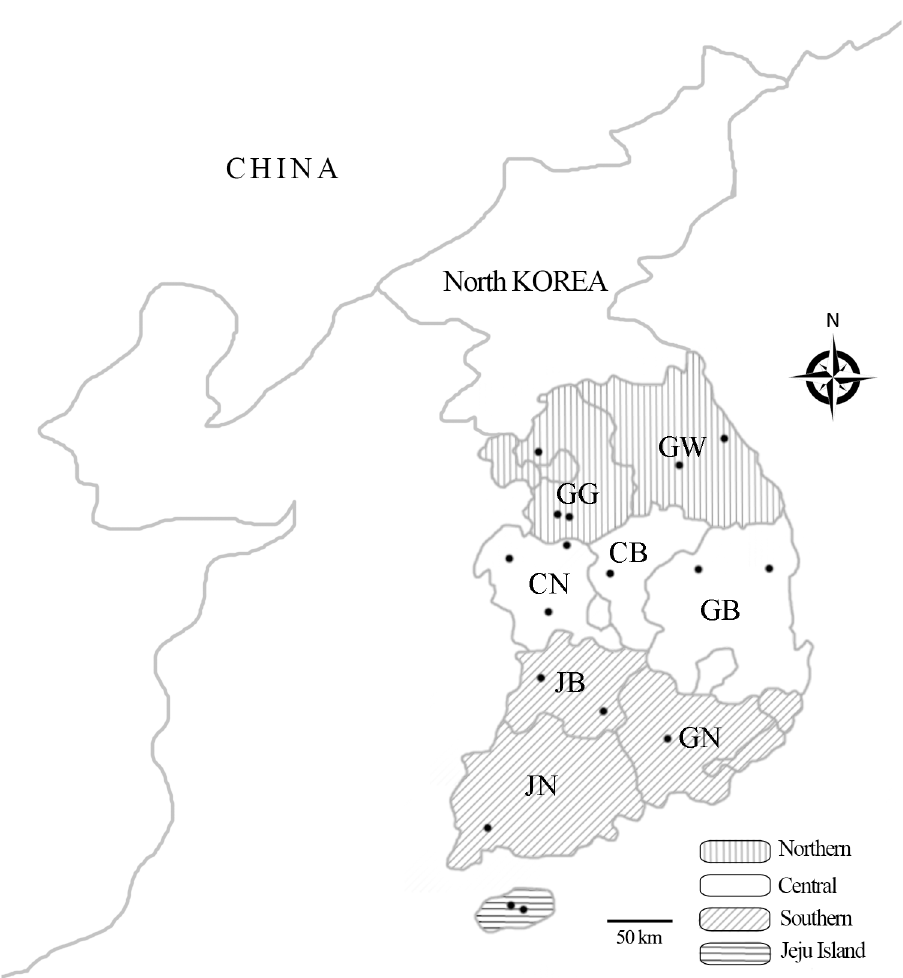
Fig 1. Geographic regions of the national breeding stock farms in South Korea. Blood samples were obtained from cattle at 17 nationalbreedingstock farms from four different regions in Korea. The four regions were the following:Northern [Gyeonggi (GG) and Gangwon (GW)]; Central [Chungbuk(CB), Chungnam (CN), and Gyeongbuk (GB)]; Southern[Jeonbuk(JB), Jeonnam(JN), and Gyeongnam(GN)]; and Jeju Island. The locationof the 17 nationalbreedingstock farms are denotedby